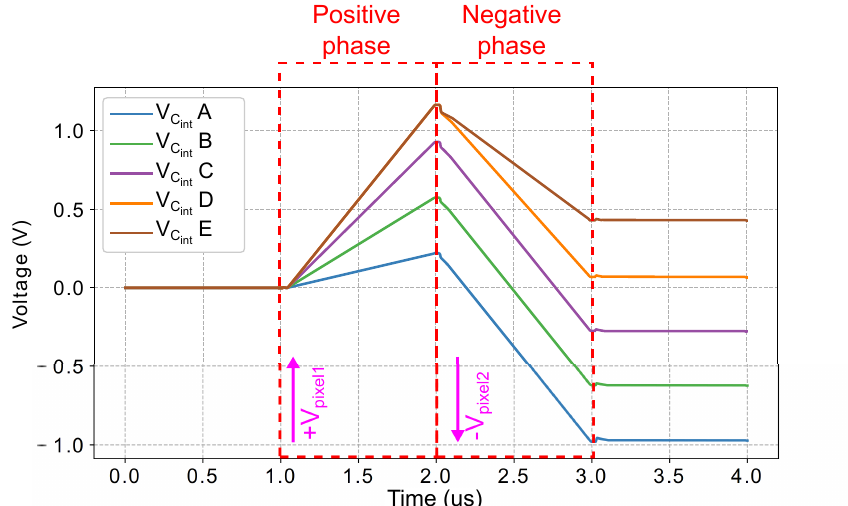
Figure 16. Postlayout simulation of five pixels in the SIS operating in local gradient mode. The graph shows the voltage across the integration capacitor of the CTIA in Figure 7 during the positive and negative integration phases shown in Figure 8.